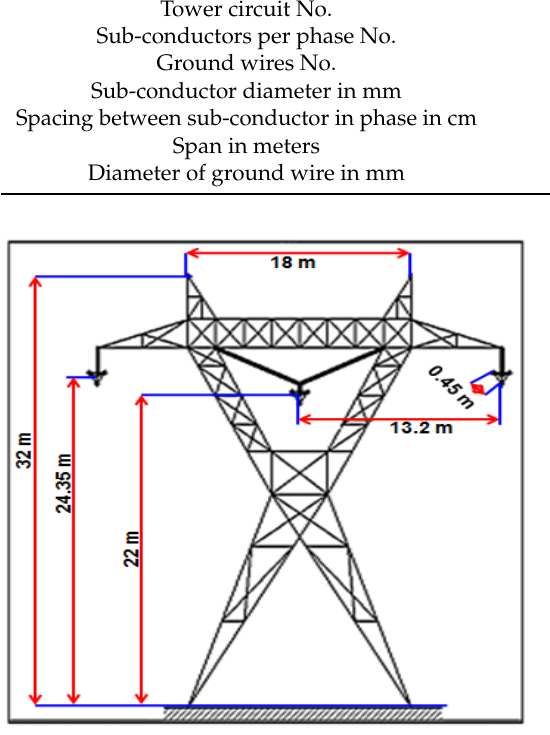
Figure 2. Tower configuration and conductor arrangements.